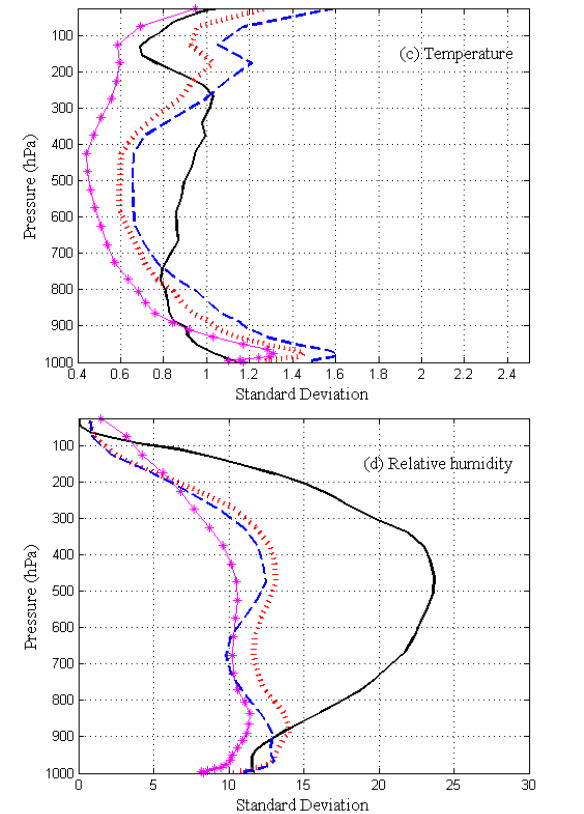
Fig. 2.Vertical profile of standard deviation of the background errors (a)Stream function (b) Velocity potential (c)Temperature (d) Relative humidity